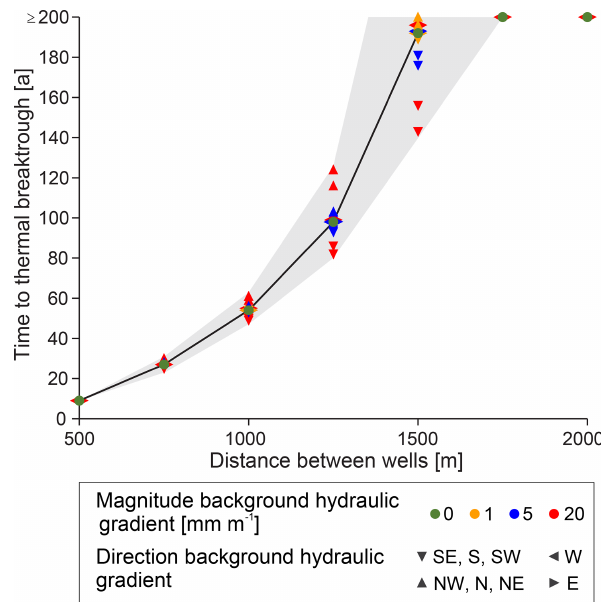
Figure 3. Time to thermal breakthrough vs. distance between in- jection and production wells. The plot contains the results of 150 simulations. For models without BHG, the relationship of time to thermal breakthrough to distance is not linear. The increasing spread observed at the greater distance is due to the influence of the BHG, which increases with distance. The basic model setup is identical to the medium porosity and permeability model ( κ = 10 − 13 m 2 and θ = 14%). The black line connects the models with zero BHG; the shaded grey area shows expected lifetimes for possible configura- tions of BHG